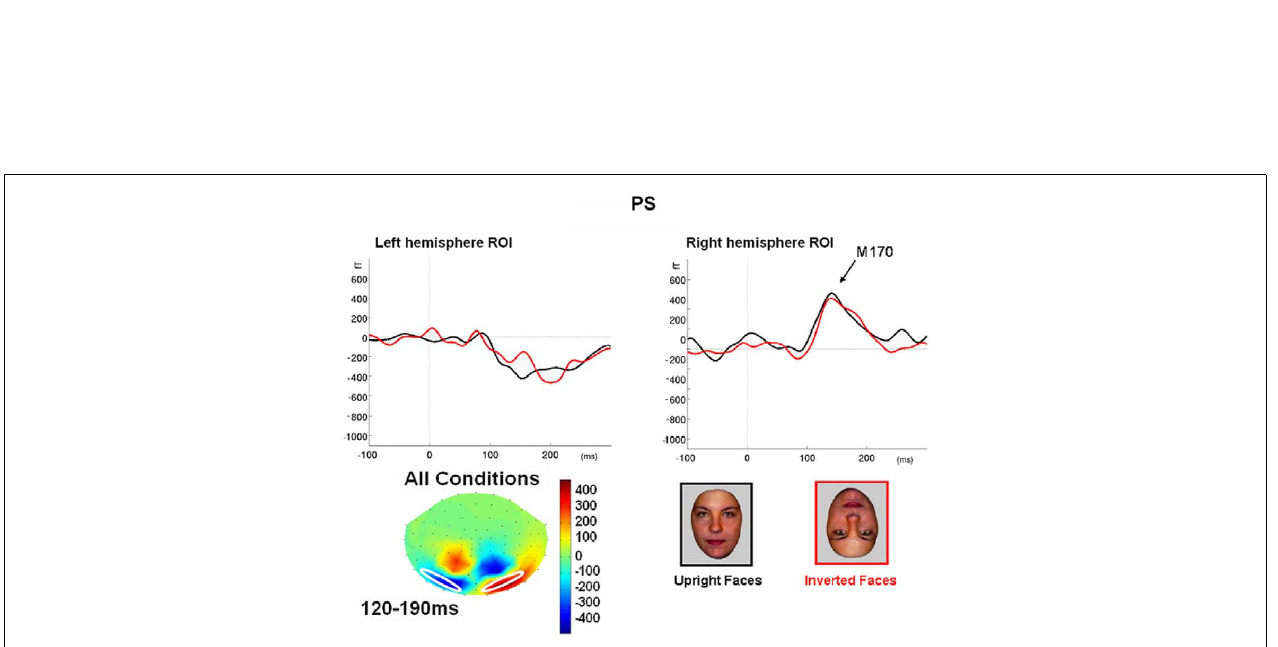
FIGUREA10 | Evoked responses averaged across three channels for the more inferior left and right ROIs in Experiment 2 (see Figure 11 for more superior ROIs). These channels were chosen as those with the maximal negative deflection vs. baseline in the left hemisphere from 120